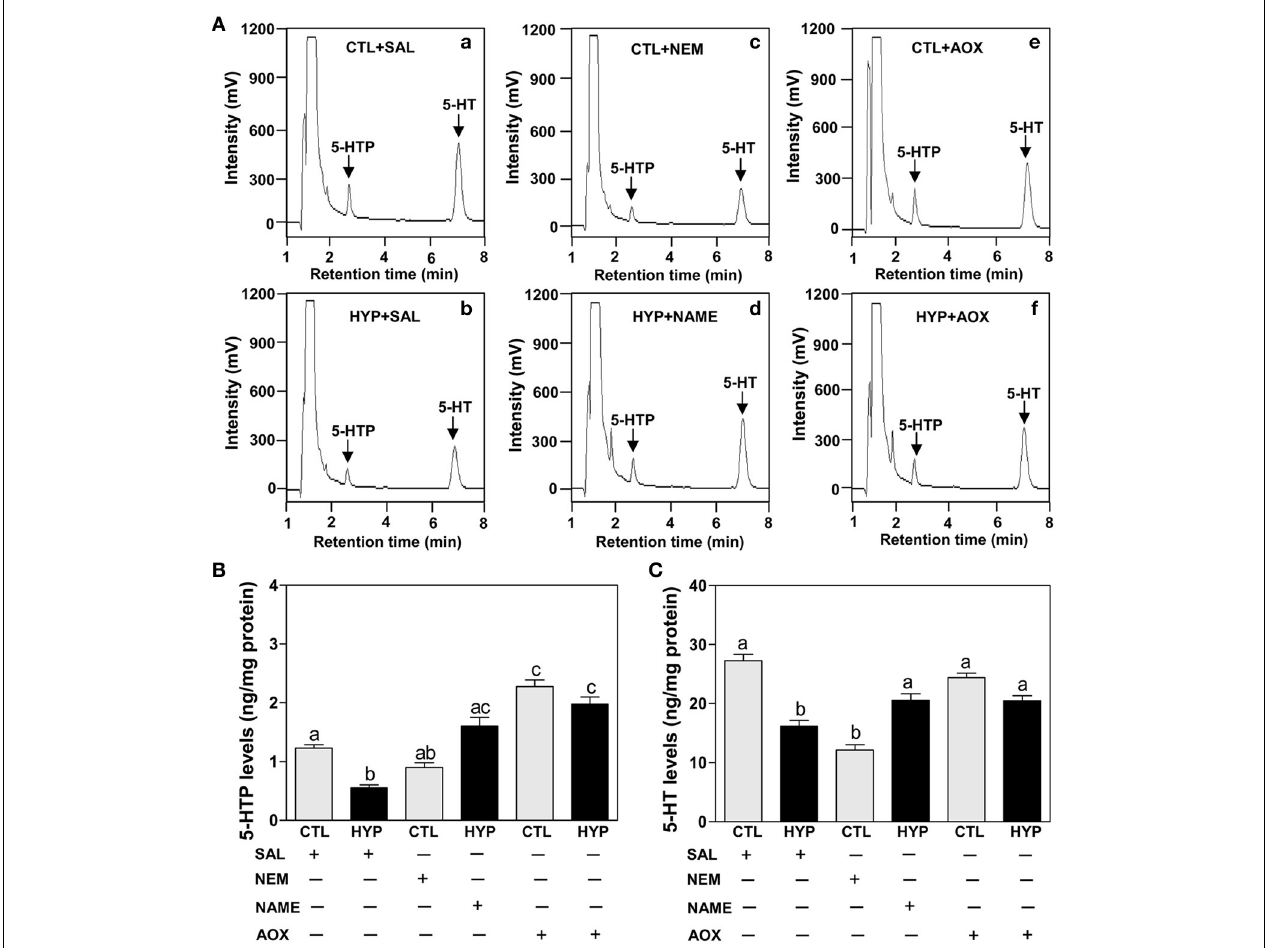
FIGURE 6 | Interactive effects of hypoxia and pharmacological agents that modulate generation of ROS and RNS on 5-HTP and 5-HT levels determined by HPLC in croaker hypothalamus. (A) Reversed-phase HPLC chromatograms of 5-HTP and 5-HT showing